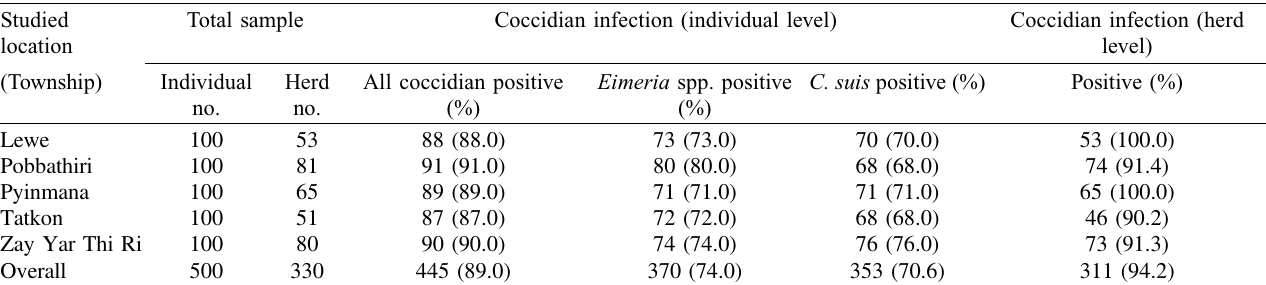
Table 1. Number of collected samples and positive samples at each sampling